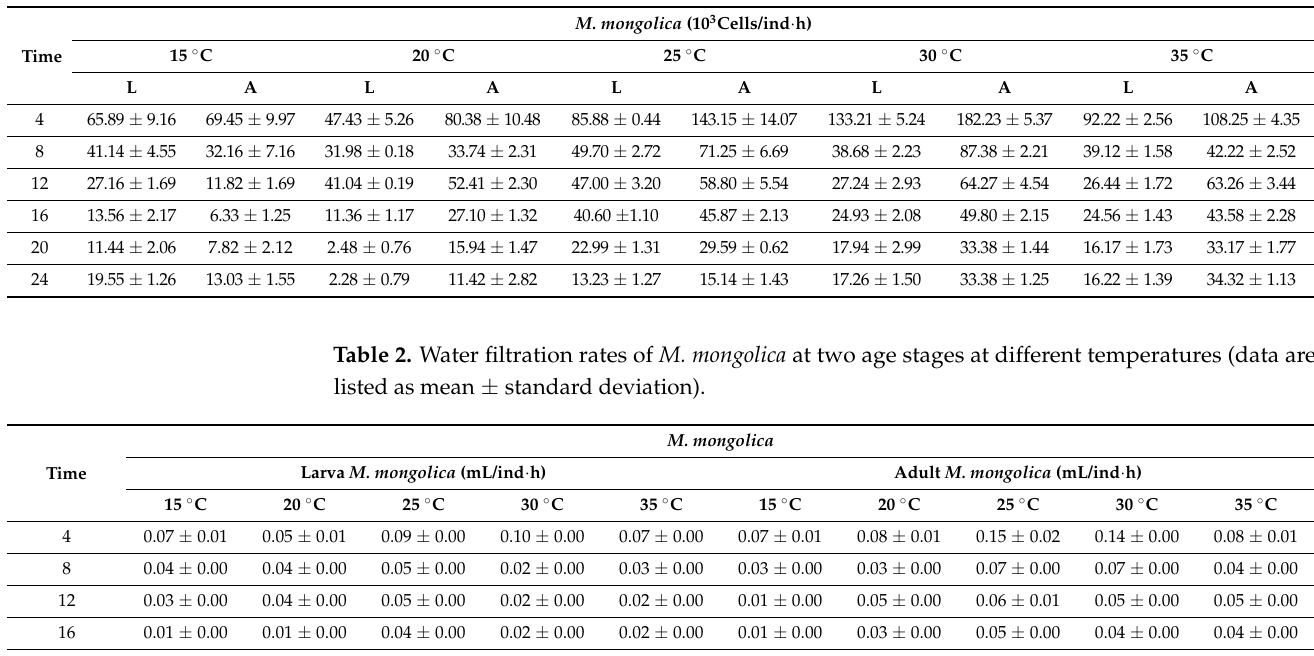
Table 1. Feeding rates of M. mongolica at two age stages at different temperatures (data are listed as mean ± standard deviation; L and A represent larva and adult M. mongolica , respectively).